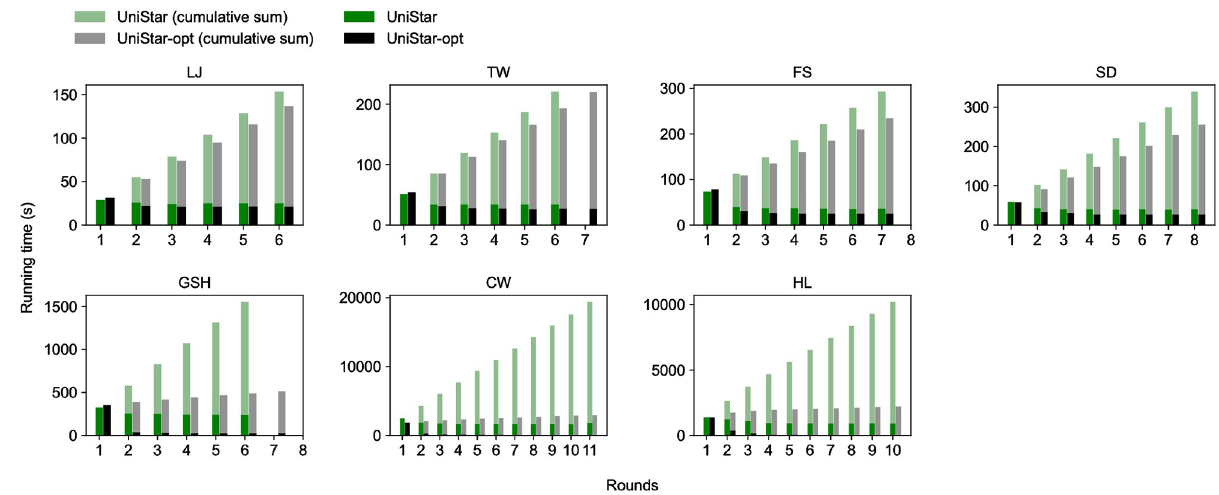
Fig 11. The running time of UniStar-opt and UniStar each round. By the edge filtering, the running time of UniStar-opt drops quickly. every round. The bars in four colors represent the decreased input sizes by four cases: excluded intact edges (Section “UniStar: The Unified Star Operation”) and filtered edges by three cases in Section “UniStar-opt: Filtering Out Dispensable Edges”. All four cases contribute greatly to reducing the size of the input data. Note that TW, FS, and GSH have only one connected com- ponent, so there are no edges filtered by case 2, in which edges belonging to early discovered connected components are filtered.